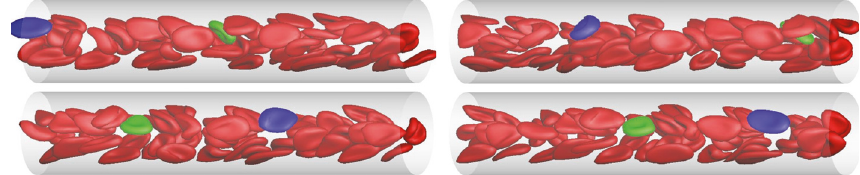
Figure 4: Snapshot of RBC motion (the hematocrit is 20%; blue: RBC near tube wall; green: RBC near tube center).